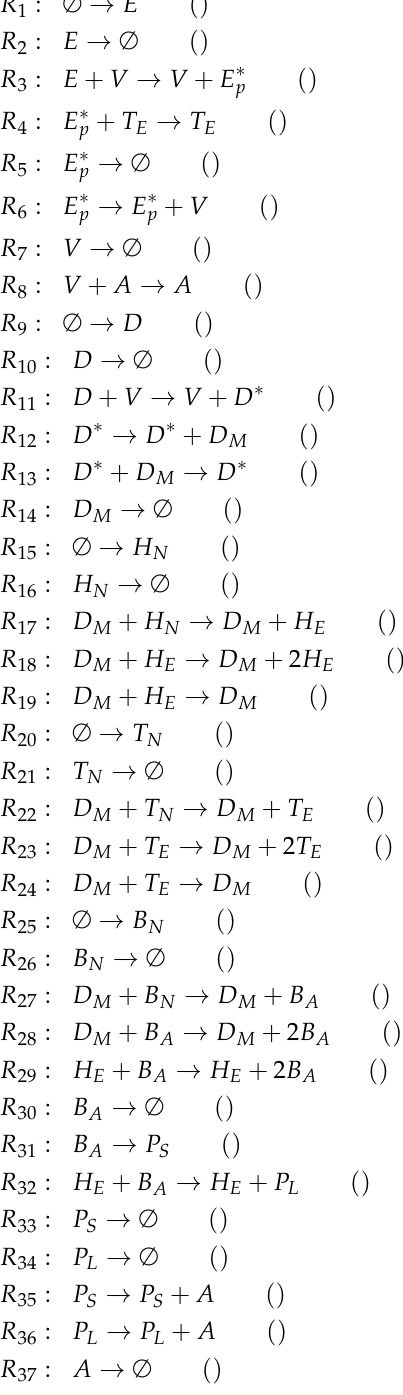
Figure A10. Reactions of Lee model